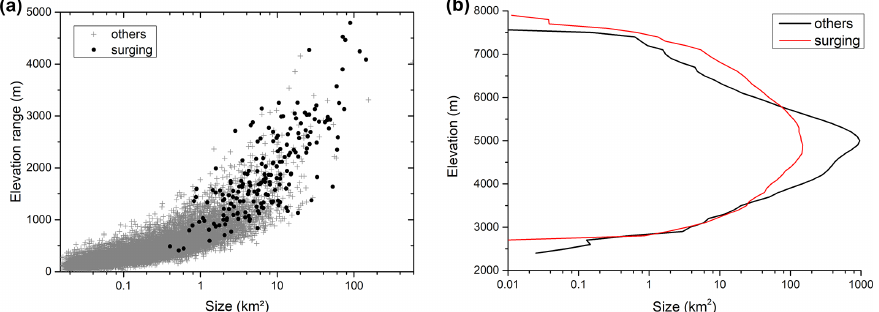
Figure 11. Comparing topographic characteristics of surging glaciers to all others. (a) Scatterplot of the elevation range vs. glacier size. (b) Glacier hypsometry for surging and other glaciers.